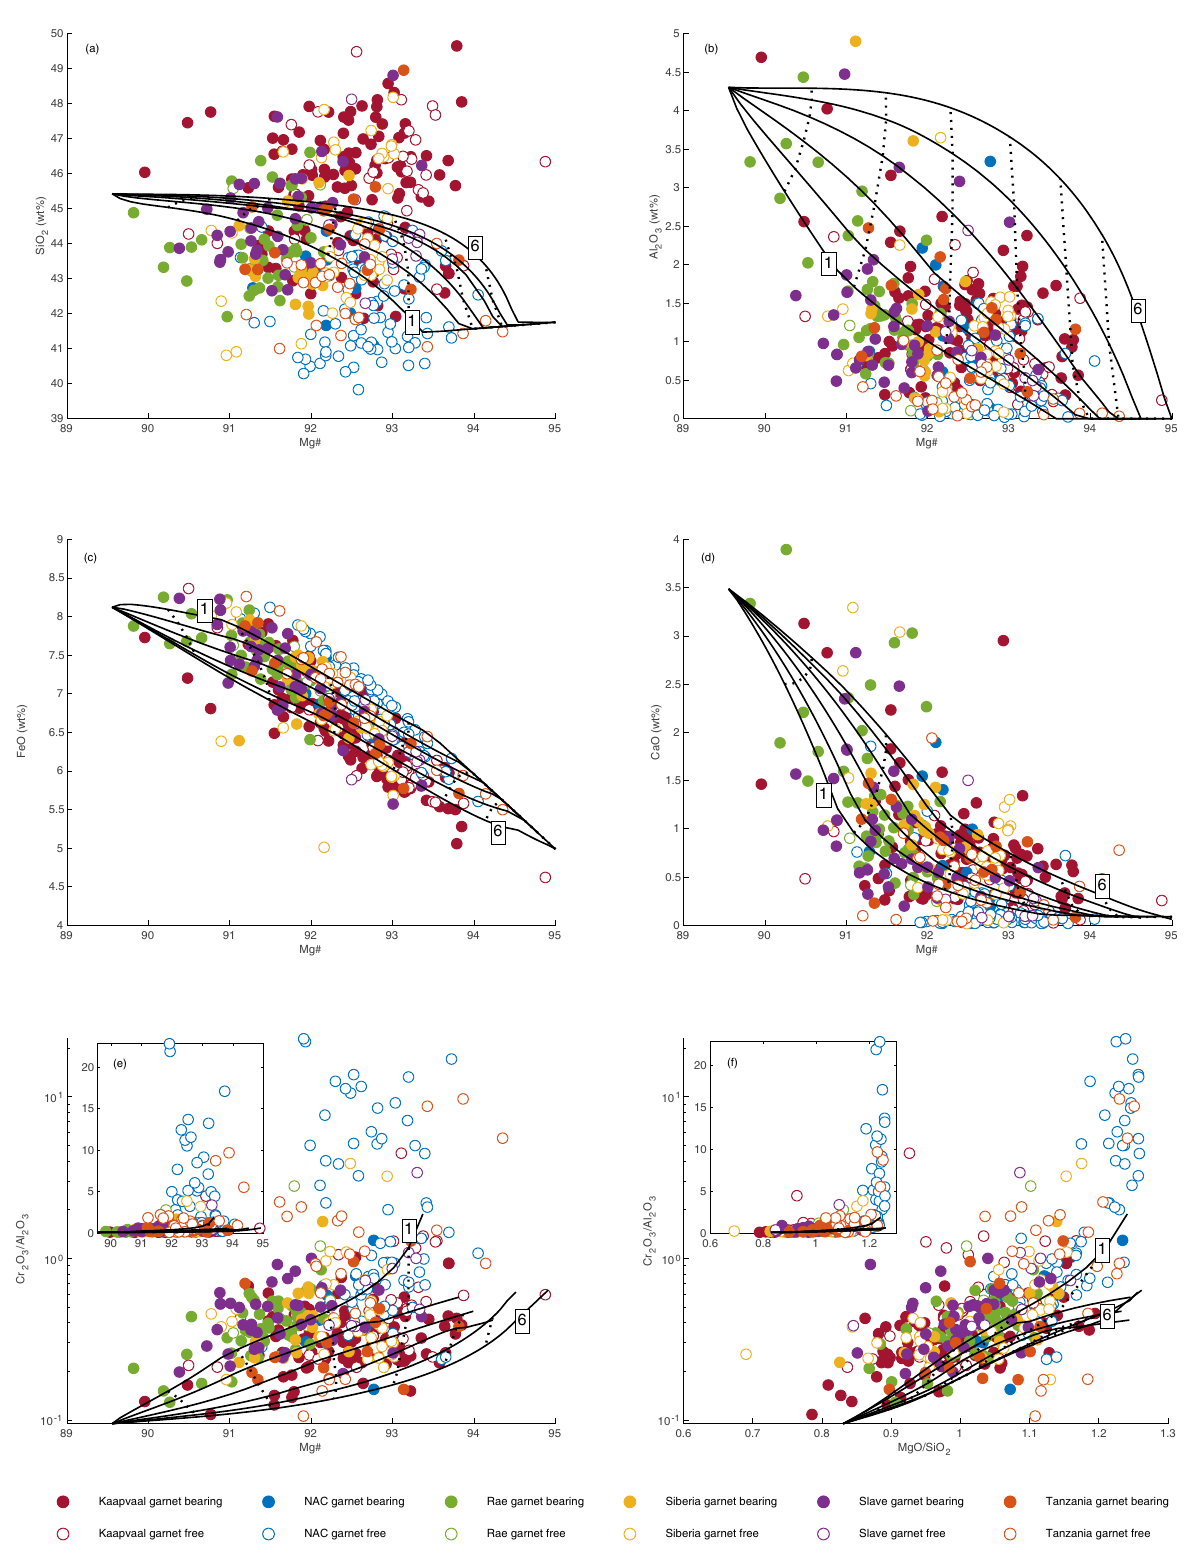
Fig. 3 Bulk compositions of individual garnet bearing (solid symbols) and garnet free (open symbols) xenoliths from Archaean cratons compared to the modelled compositions of residues of melting of fertile peridotite KR4003. ( a ) Mg# - SiO 2 , ( b ) Mg# - Al 2 O 3 , ( c ) Mg# - FeO, ( d ) Mg# - CaO, ( e ) Mg# - Cr 2 O 3 /Al 2 O 3 , ( f ) MgO/SiO 2 - Cr 2 O 3 /Al 2 O 3 . Pressure is shown in 1GPa increments from 1 to 6GPa (solid lines, low and high pressures are labelled) and degree of melting is marked in 10% increments (dotted lines). Note log scale in parts e and f, the insets show the same data on a linear